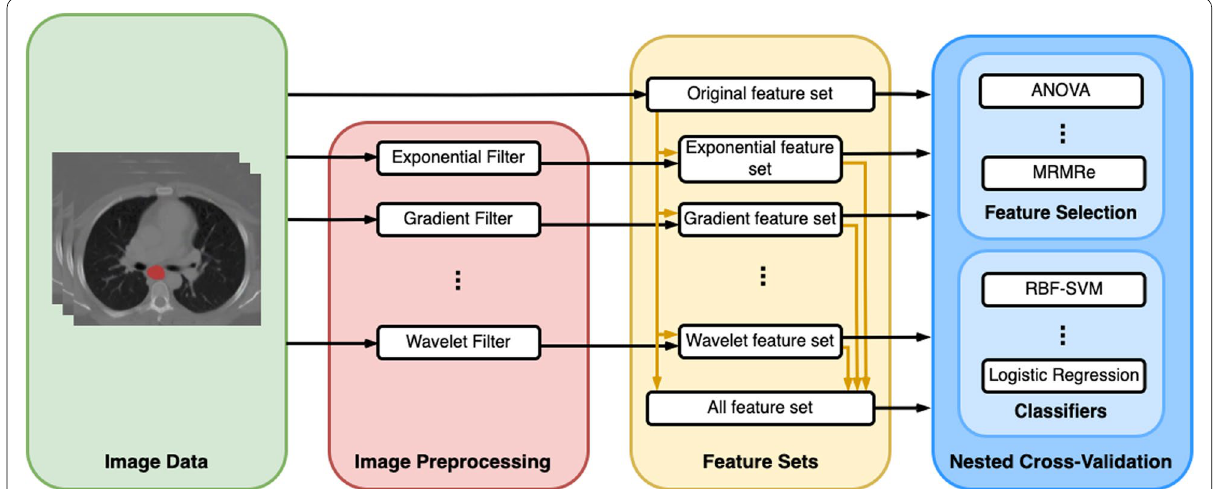
Fig. 1 Overall pipeline used for training. The image data was preprocessed by each filter to generate the different feature sets. A 10-fold nested, stratified cross-validation was applied to train a predictive